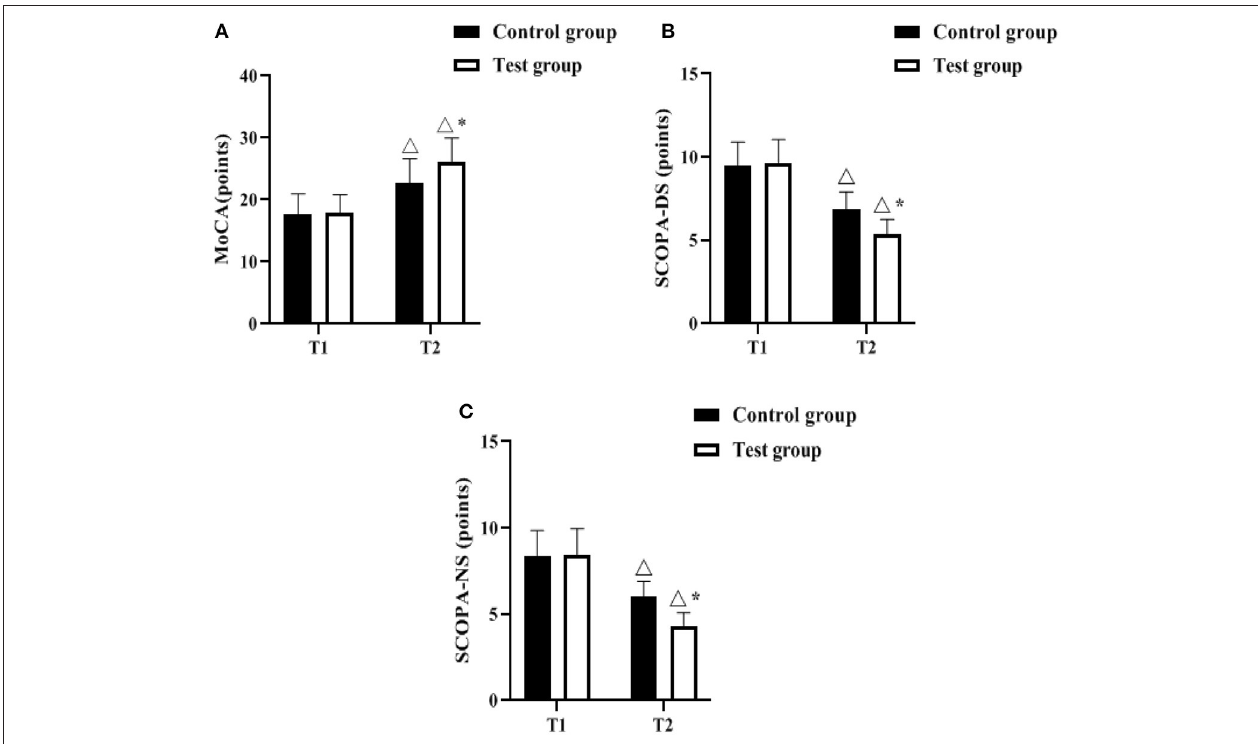
FIGURE 1 | Comparison of non-motor symptoms ( n , x ± s). (A–C) indicate the MoCA, SCOPA-DS, and SCOPA-NS scales, respectively. Icon 1 indicates the difference between T2 period and T1 period between the same groups, P < 0.05. Icon * indicates the difference between the two groups in T2 period, P < 0.05.